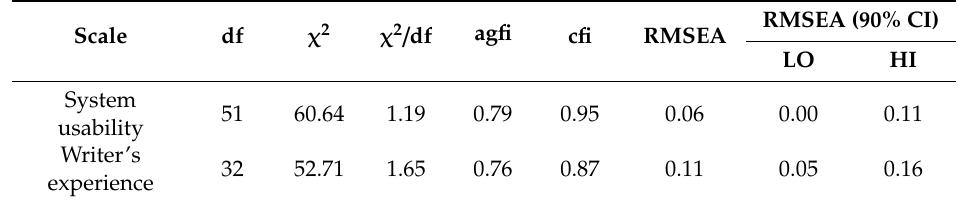
Table16. Structure-modelfitindicesofthetwoindicatorsof“systemusability”and“writer’sexperience” yielded by the CFA process a .